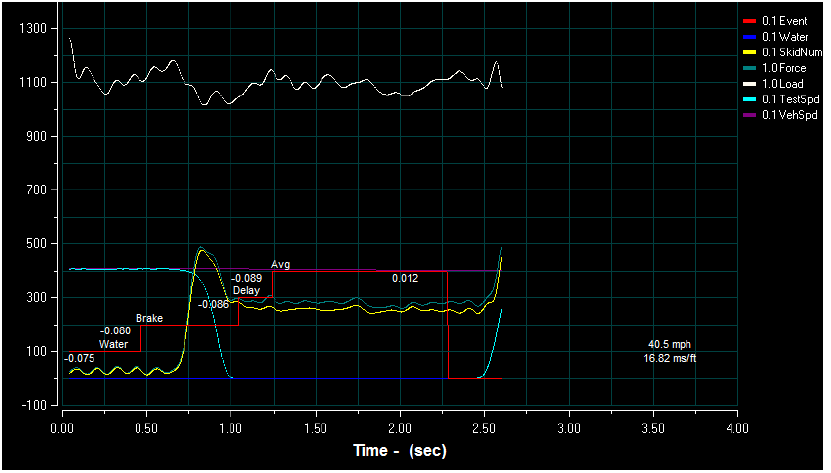
Figure 1. A screenshot of the test output from a locked wheel trailer showing SN, rolling test tire speed, vehicle speed, and other test variables.